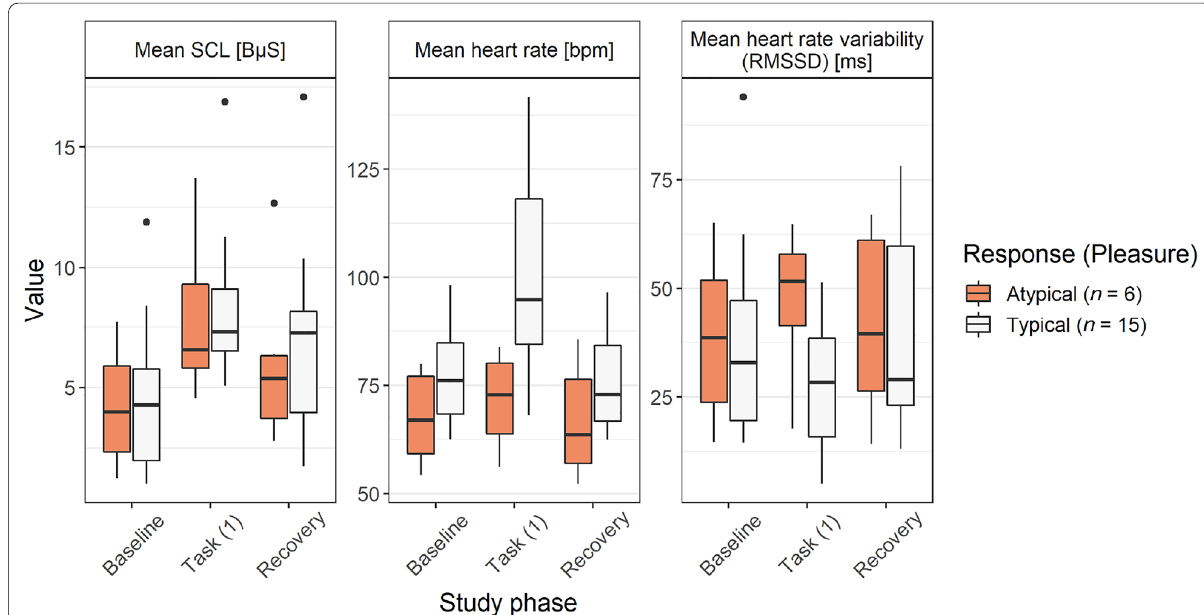
Fig. 8 Physiological activity across study phases, split by participants with atypical and typical pleasure score patterns